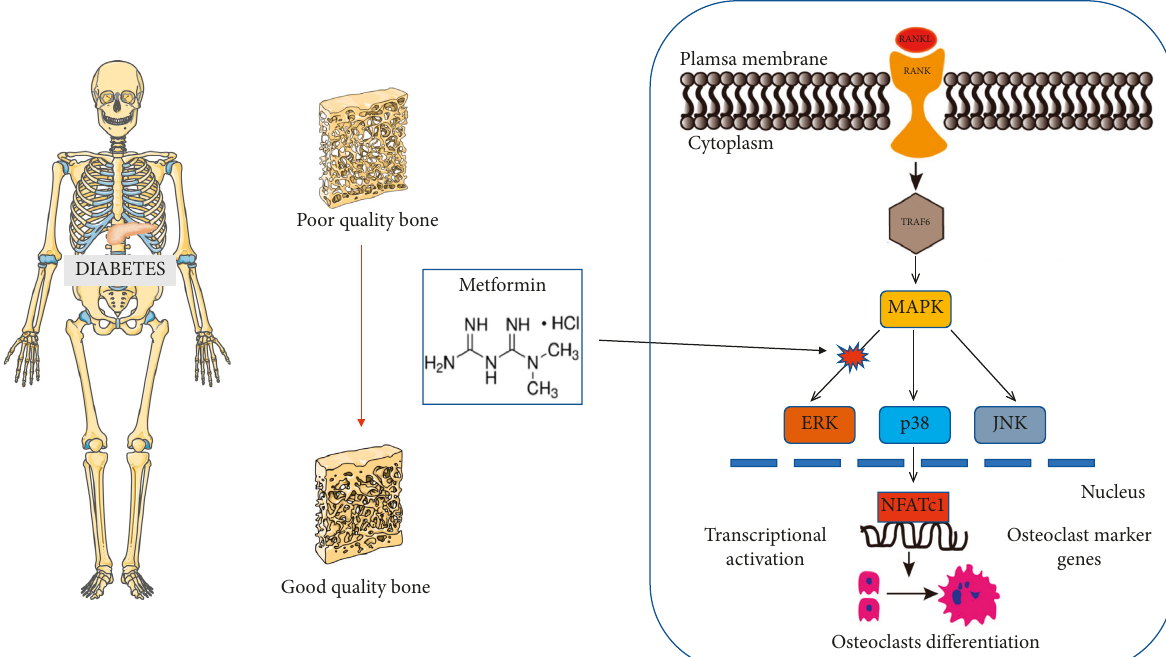
Figure 6: Graphical abstract. The present study demonstrates that Met inhibited osteoclastogenesis and the expression of osteoclasto- genesis-related genes mainly via suppressing the ERK signaling pathway. These findings suggest that Met might be an effective therapy for